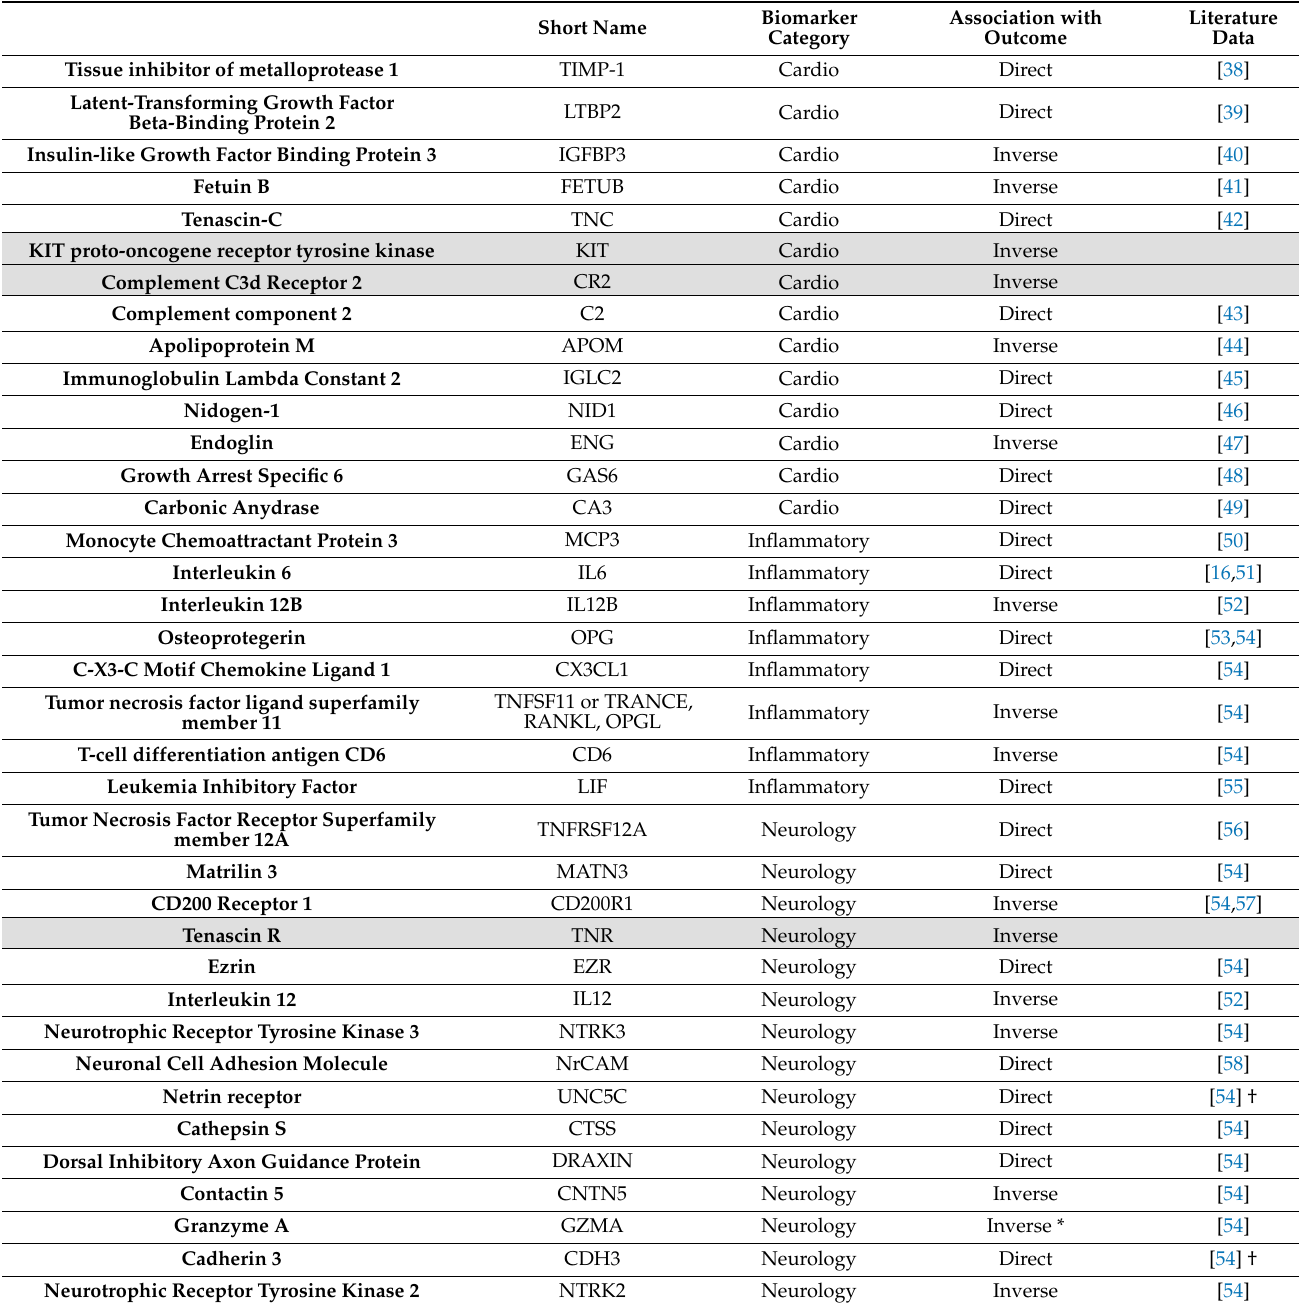
Table 3. Summary of elastic net logistic regression analyses of biomarkers associated with disease